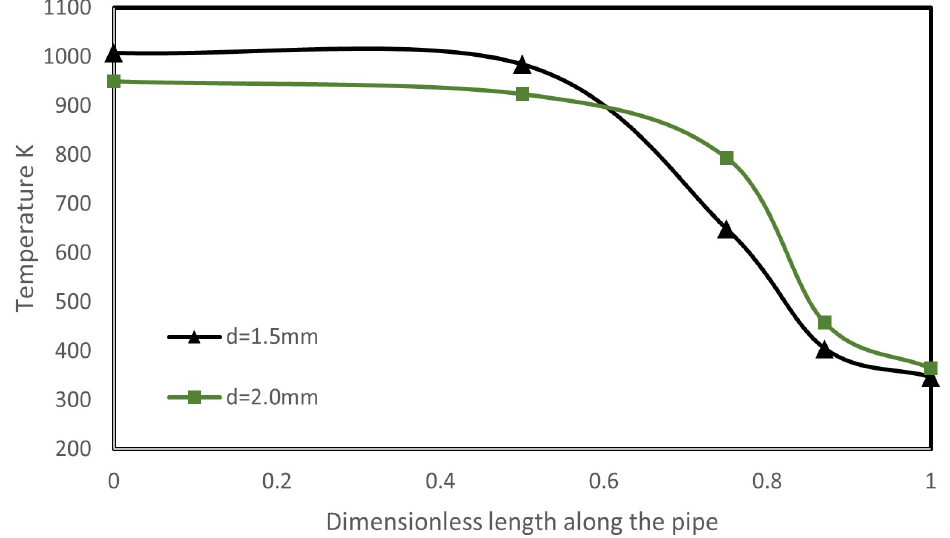
Figure 6. Temperature profiles with two pipe inner diameters (The dimensionless length along the pipe is the ratio between the distance from the evaporator end and the total pipe length; data from [14]).